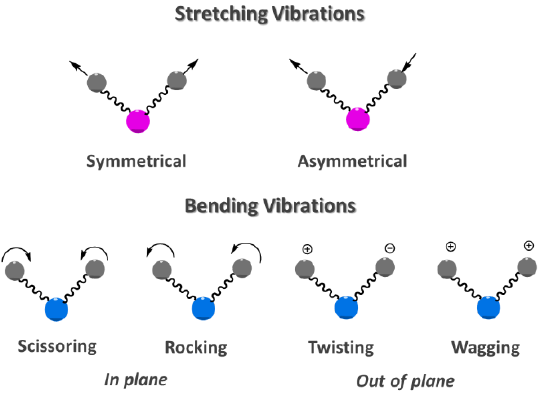
Figure 1. Major stretching and bending vibrational modes.